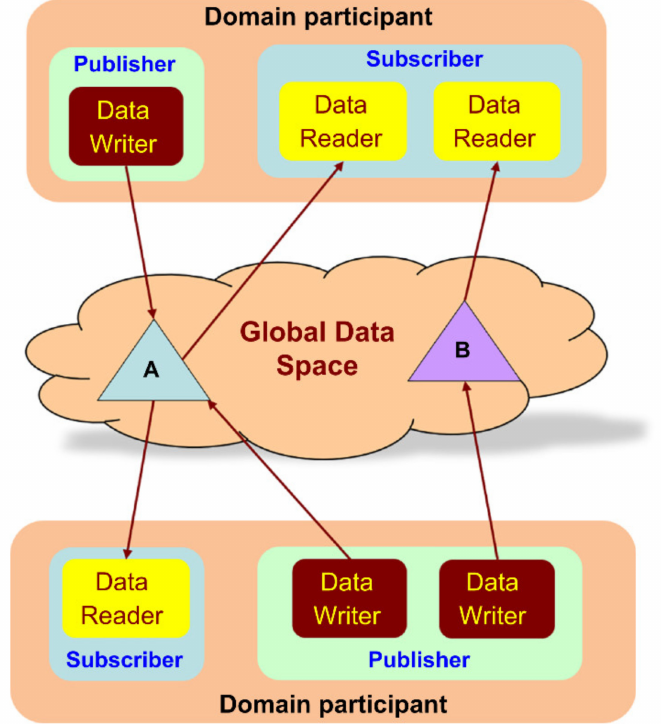
Figure 4. Correlation between DDS domain participants and topics.